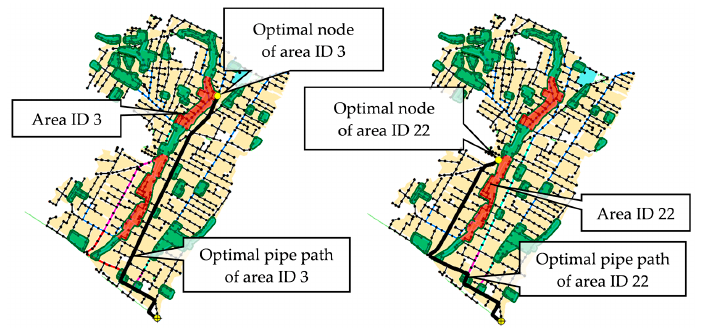
Figure 8. Optimal nodes and pipe paths of areas ID 3 and ID 22.